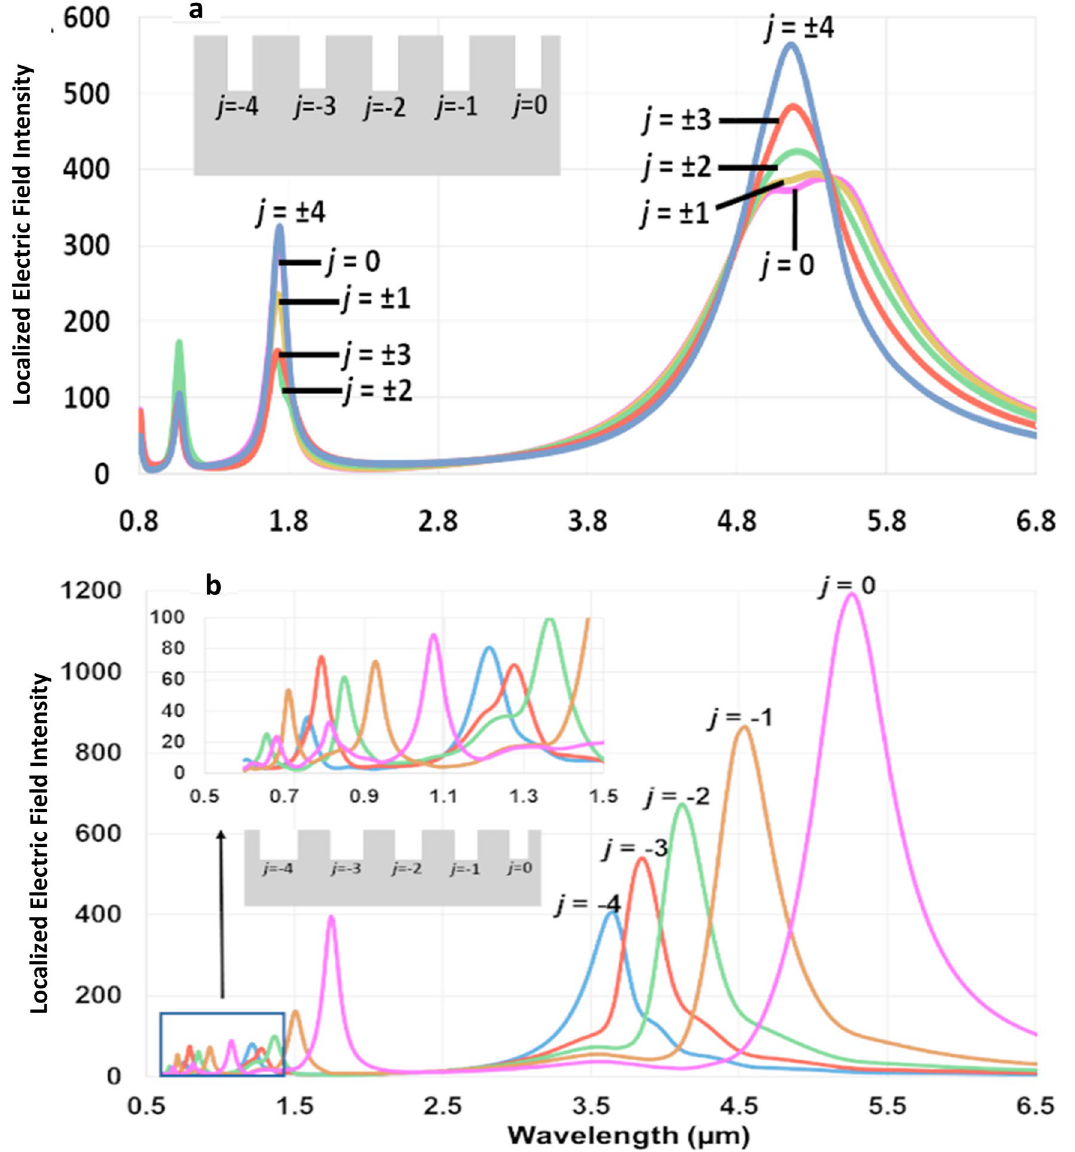
Figure 5. ( a ) Localized electric field intensity for a uniform grating with L = 500 nm, w = 10 nm, n = 9 and − 4 ≤ j ≤ + 4. All the nano-grooves localize identical plasmonic modes, except around the first excited mode around 5 mm where small variations in the resonance mode of different grooves are noted, ( b ) localized electric field intensity for a non-symmetric graded grating with L = 500 nm, w = 10 nm, Δ = 5 nm, n = 5 and − 4 ≤ j ≤ 0. Every groove resonates at a particular wavelength of light, and impedance matched graded grating exhibits a multiwavelength mode localization in a wide bandwidth of 600 nm to 6 µm. This multiwavelength localization is resulted from adiabatic mode (as shown in Fig. 5b for d = 300 nm). Under adiabatic mode transformation, the graded grating is impedance- matched, that is, each groove resonates strongly at a single wavelength while transferring their non-resonant modes to an adjacent groove(s) so that the modes overlap with the resonant mode of the neighbouring groove(s). Figure 6 shows how adjacent grooves couple and guide their non-resonant modes to the neighbouring reso- nating mode in an impedance-matched graded grating. The blue vectors pointing to the right (left) correspond to positive (negative) values of the real part of the x -component of the electric field (Re( −→ E x ) ). The resonating 2 E x E groove, indicated on the figure, exhibits the highest field strength | (cid:31) + = (cid:30) | (cid:29) evidently corresponds to the highest total power dissipated at the bottom of the groove. Re ( −→ E x ) of the resonating groove points to the right while the field in all the other grooves point toward the resonating groove. For example, when groove j = 0 (Fig. 6a) is at resonance (at λ resonant = 5.264 μm), Re ( −→ E x ) of all the other grooves point towards it. Similarly, when groove j = − 1 is at resonance (at λ resonant = 4.478 μm), Re ( −→ E x ) of all the other grooves point